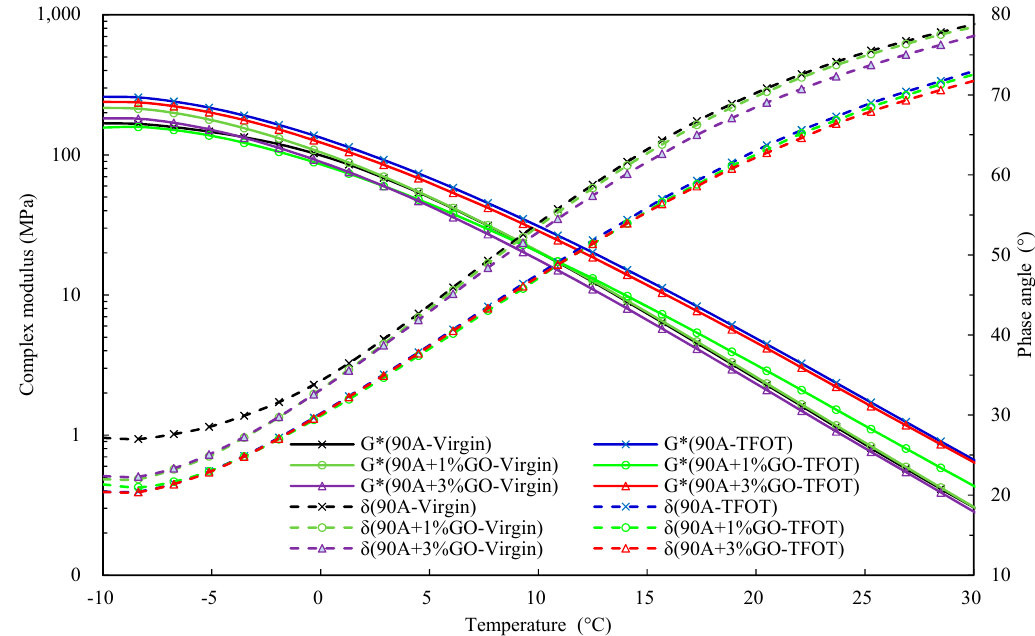
Figure 9. Complex modulus of 90 A and GO modified 90 A before and after TFOT.